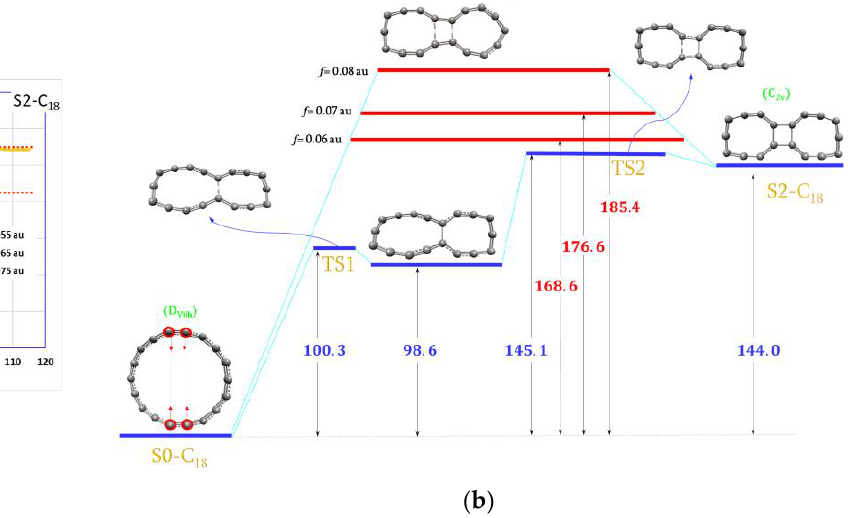
Figure 2. ( a ) The algorithmic reaction path (the geometry optimization history) with the marked transition state energy values; ( b ) the energy diagram with the estimated upper limit of the energy demand for the formation of the S2-C 18 molecule. All values in the energy diagrams are in kcal/mol. Note that by squeezing C 18 , new moieties are introduced: 9-membered and 4-membered